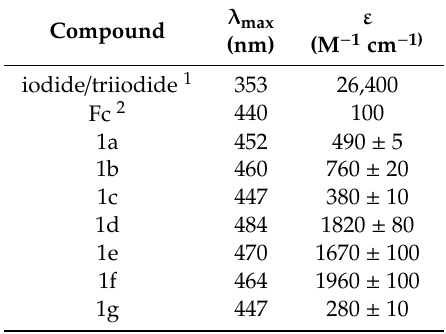
Table 1. Absorption maxima and molar extinction coe ffi cient of Fc-based derivatives 1a–1g (EtOH).